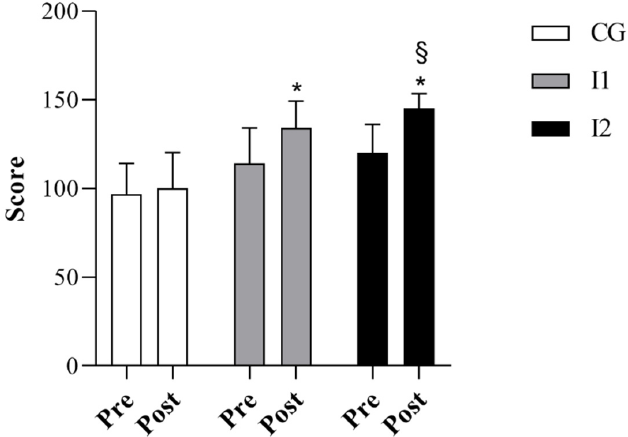
Figure 3. The score of object control skills in CG, I1 and I2 group. * p < 0.001 I1 and I2 vs. CG; § p < 0.05 I2 vs. I1.